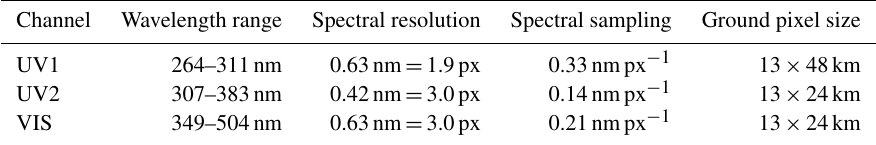
Figure 1. An impression of OMI flying over the Earth. The spectrum of a ground pixel is projected on the wavelength dimension of the charge-coupled device (CCD; the columns). The cross-track ground pixels are projected on the swath dimension of the CCD (the rows). The forward speed of 7kms − 1 and an exposure time of 2s lead to a ground pixel size of 13km in the flight direction. The viewing angle of 114 ◦ leads to a swath width on the ground of 2600km. Table 1. Optical properties for the three channels UV1, UV2 and VIS.